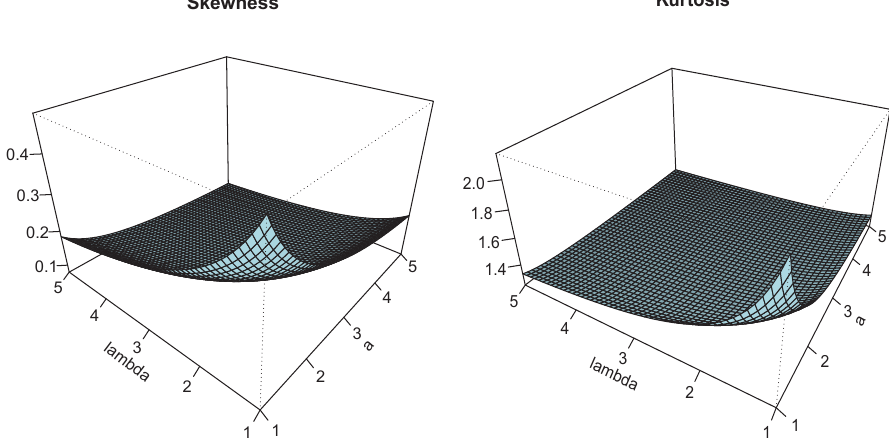
and γ ∗ for λ , a ∈ ( 1,5 ) and b = 2 1